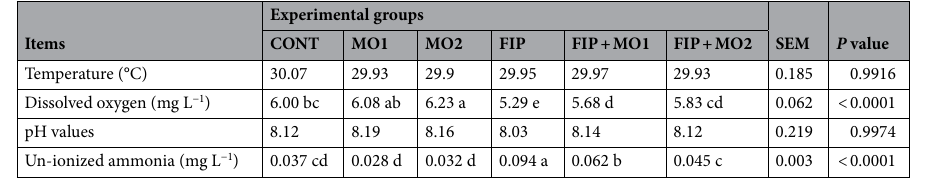
Table 1. Water quality parameters in the rearing aquaria of Nile tilapia groups during the present study. Data represent means ± S.E.M—means having different letters in the same row are significantly different at P < 0.05.